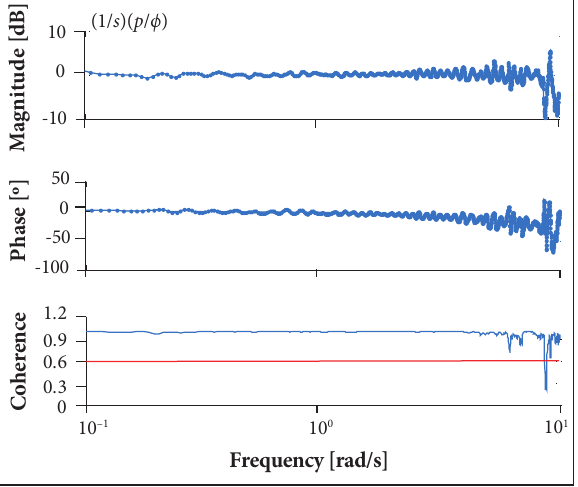
Figure 8. Frequency-domain angular consistency – lateral